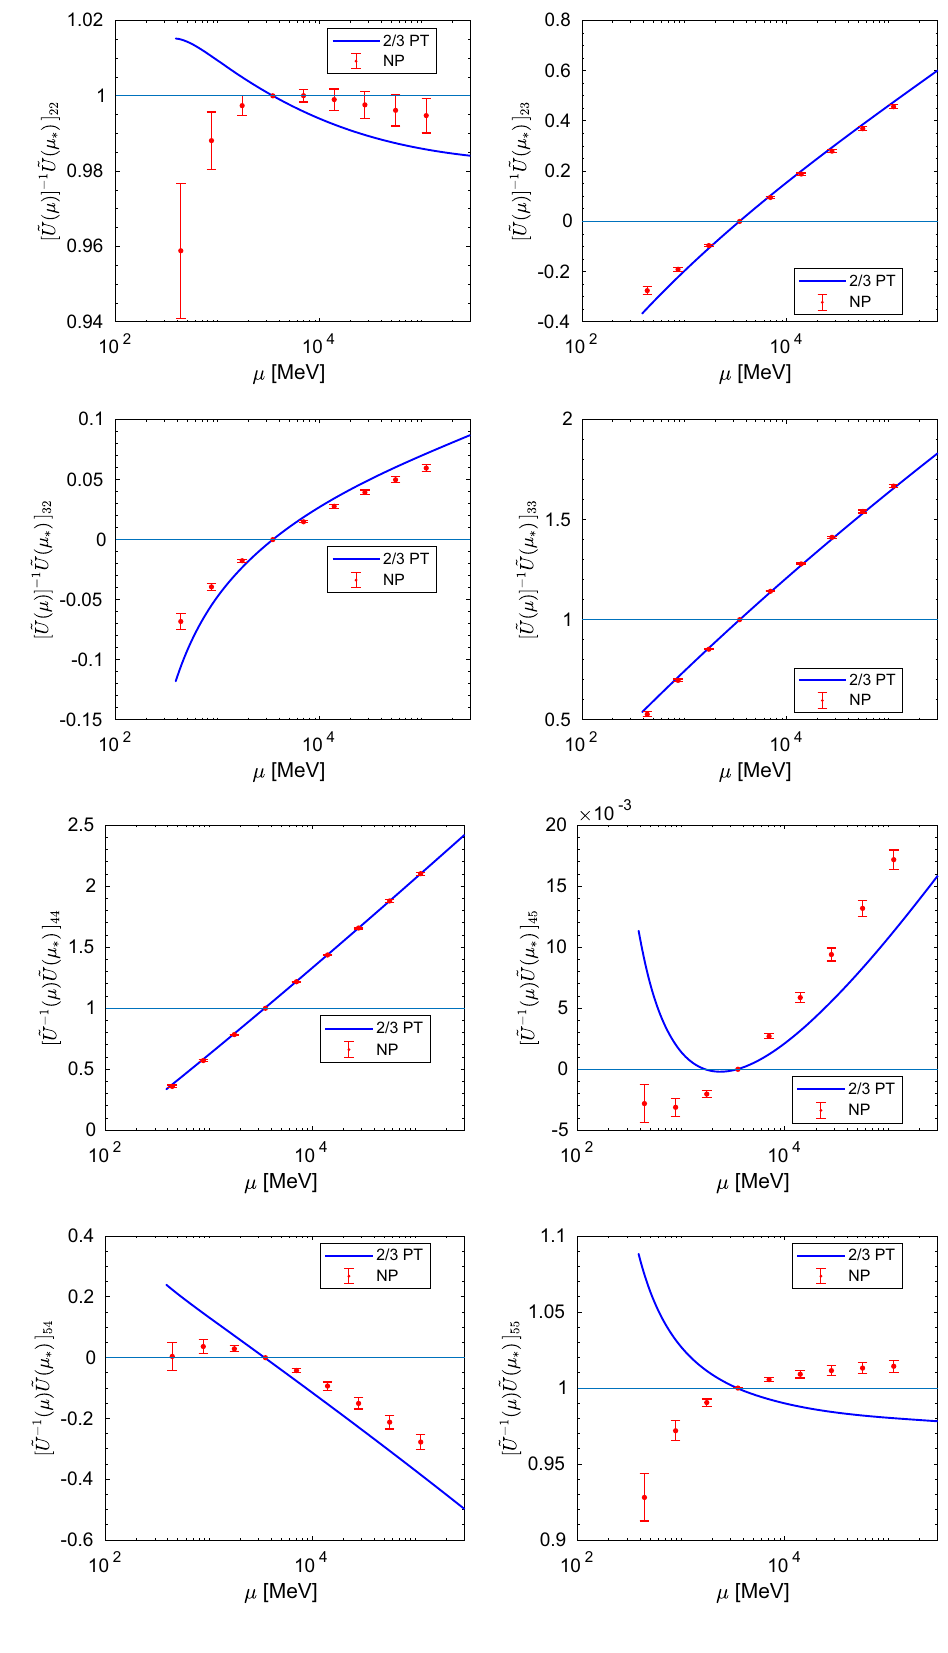
Fig. 13 Non-perturbative evolution factor U − (μ,μ ∗ ) = [ ˜ U − (μ) ] − 1 ˜ U − (μ ∗ ) , where μ ∗ = 3 . 46GeV, for the operator , Q − } (top) and for bases { Q − 2 3 { Q − , Q − } (bottom). Results are 4 5 compared to the perturbative prediction, obtained by numerically integrating Eq. (2.23), with γ (at NLO) and β (at NNLO) in the SF